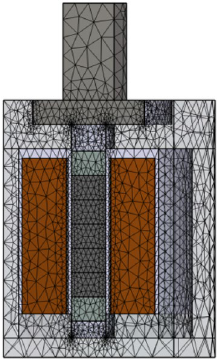
Figure 10. Finite element model of longitudinal vibration GMT.